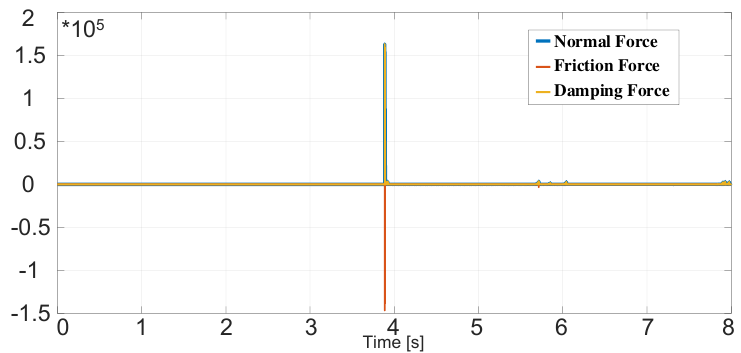
Figure 15. Contact forces between the first dumbbell and the target shelf.